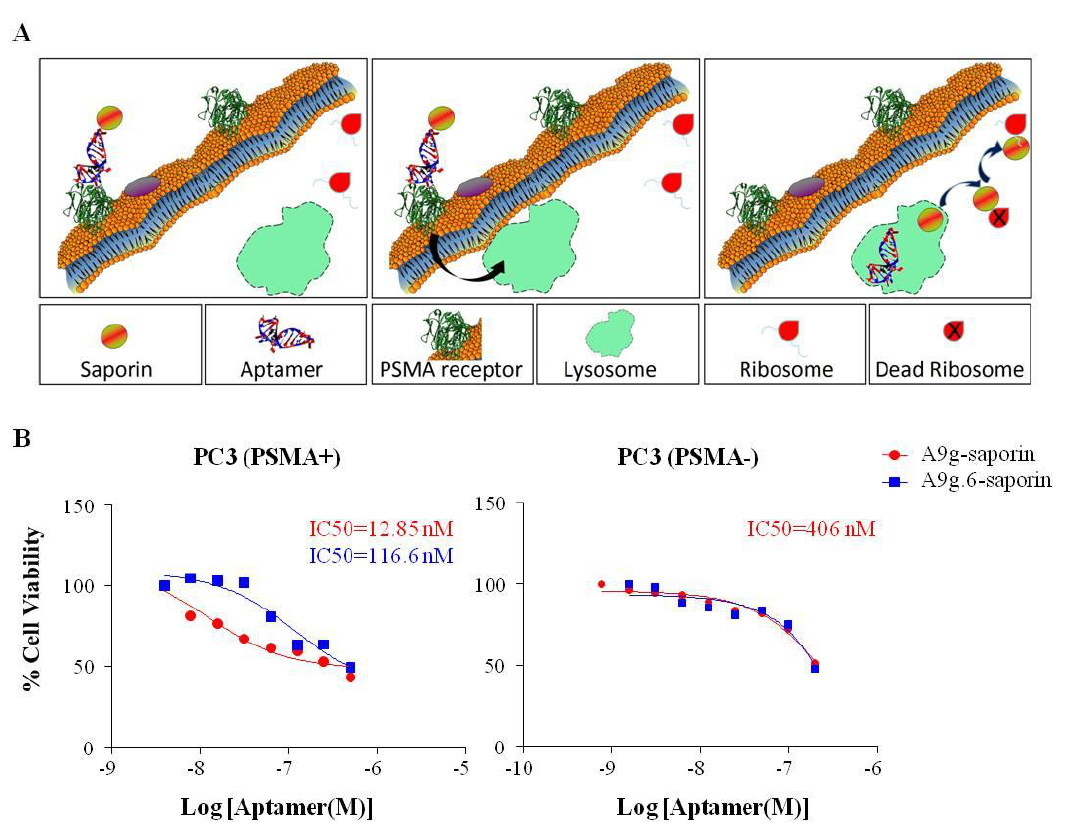
Figure 6. RNA-RIP assay. (A) Schematic of A9g-saporin conjugate internalization and RIP effect leading to cell death. (B) Dose dependent response of A9g-saporin and control, A9g.6-saporin, conjugates in PC3(PSMA+) ( left ) and PC3(PSMA–) cells ( right